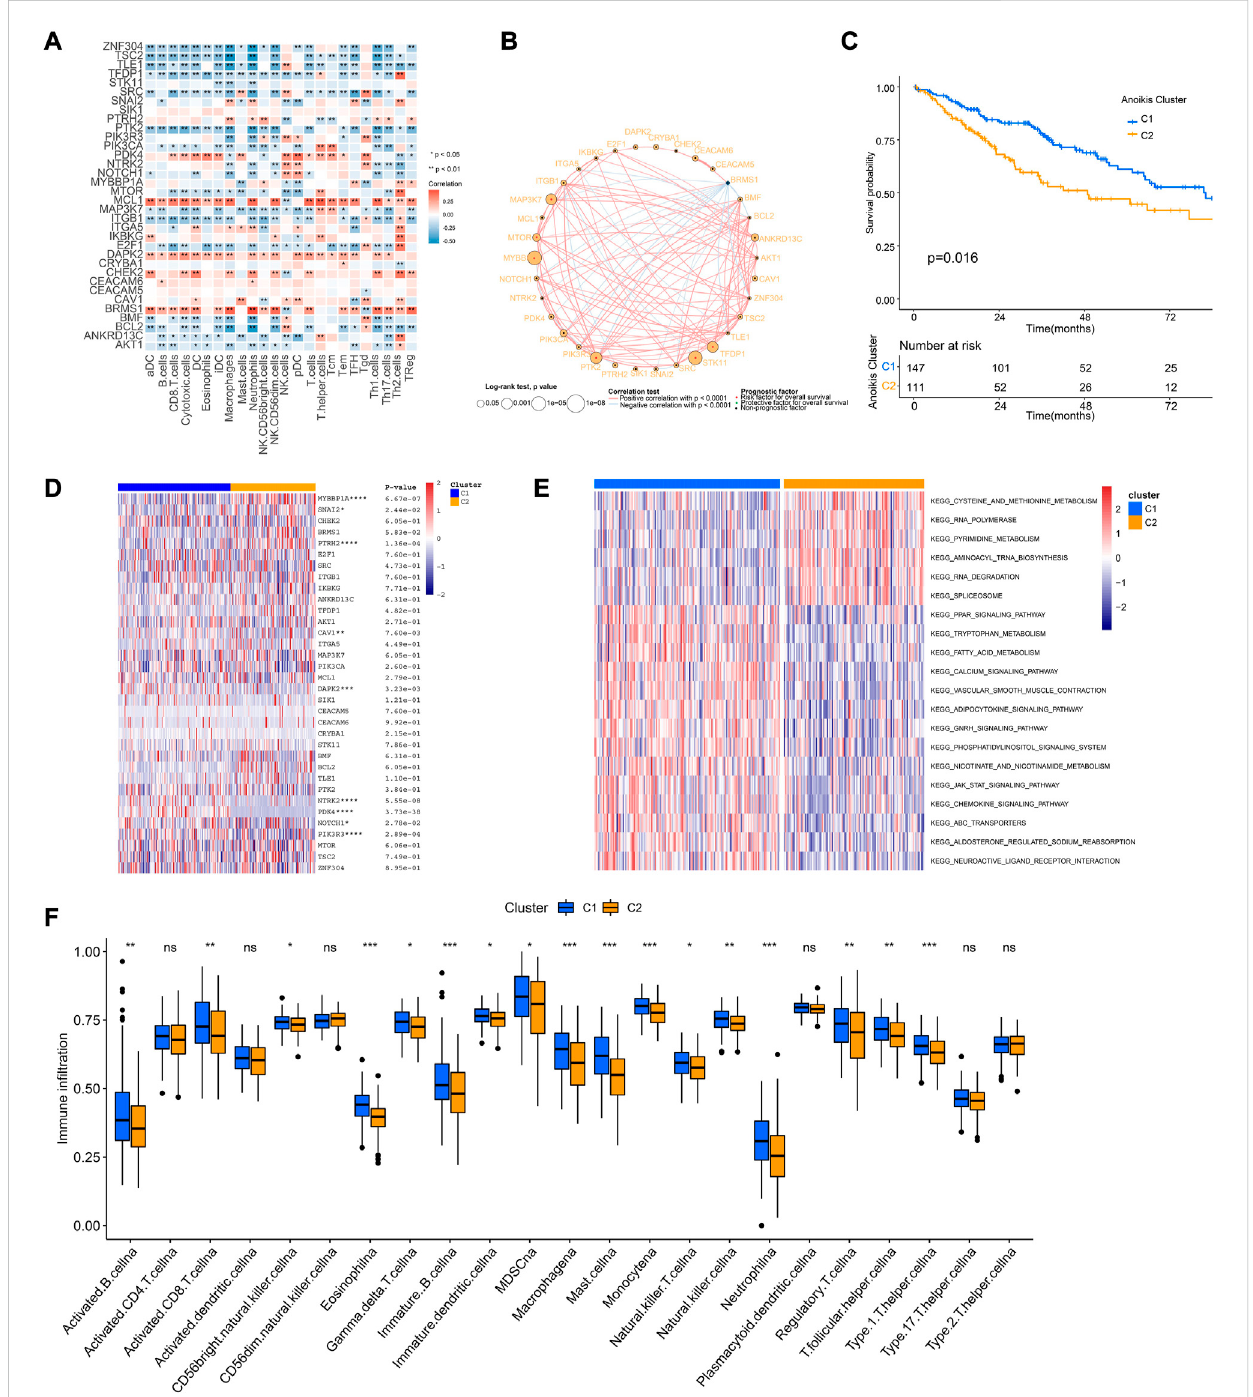
FIGURE 4 Cross-talk of ARGs and identi fi cation of Anoikis clusters. (A) The correlation analysis of the expression of ARGs and signatures of immune cells. Red indicatedpositivelyassociatedand blueindicatednegatively associated. (B) The correlationnetworkofARGs intheTCGA-SARCcohort. Thesigni fi cance of the prognostic effects was illustrated by the circle size. (C) The Kaplan-Meier curve comparing the survival between different Anoikis clusters. (D) The heatmap of ARGs between different Anoikis clusters. (E) The gene set variation analysis (GSVA) illustrating pathways signi fi cantly enriched between different Anoikis clusters. (F) The in fi ltrations of different immune cells between different Anoikis clusters. *, 0.01 ≤ p < 0.05; **, 0.001 ≤ p < 0.01; ***, 0.0001 ≤ p < 0.001; ****, p < 0.0001; ns, p ≥